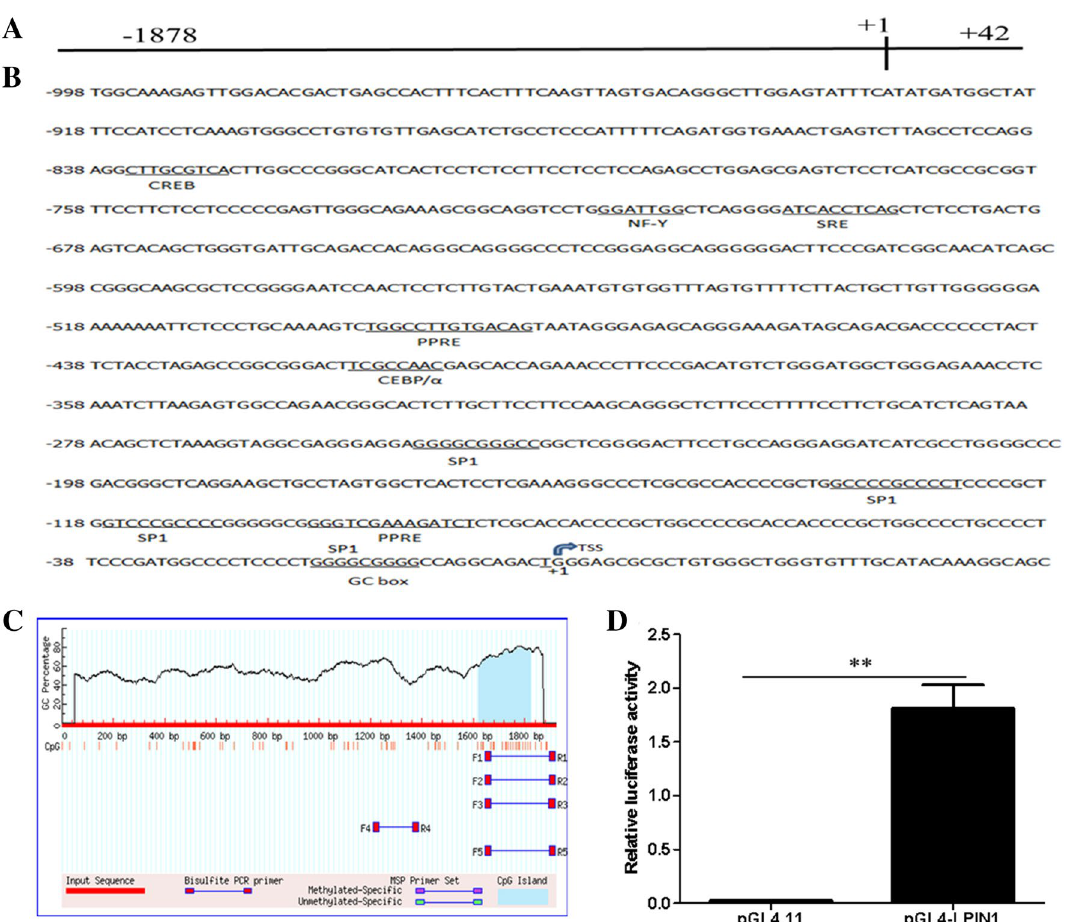
Figure 4. Sequence identification and activity analysis of buffalo LPIN1 promoter. ( A ) Fragment length of the amplified LPIN1 promoter; ( B ) Analysis of regulatory elements in the promoter sequence of LPIN1 gene; ( C ) The prediction of CpG island; ( D ) The luciferase activity of LPIN1 promoter. **, P < 0.01.